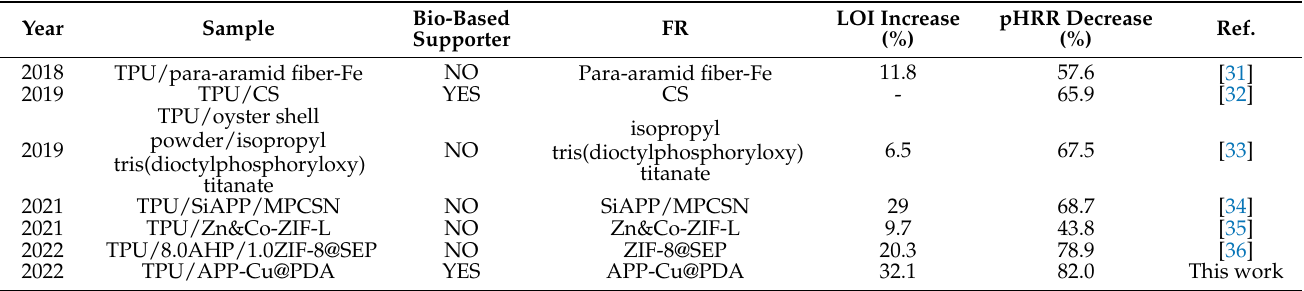
Table 5. Flame-retardant properties of TPU composites in the